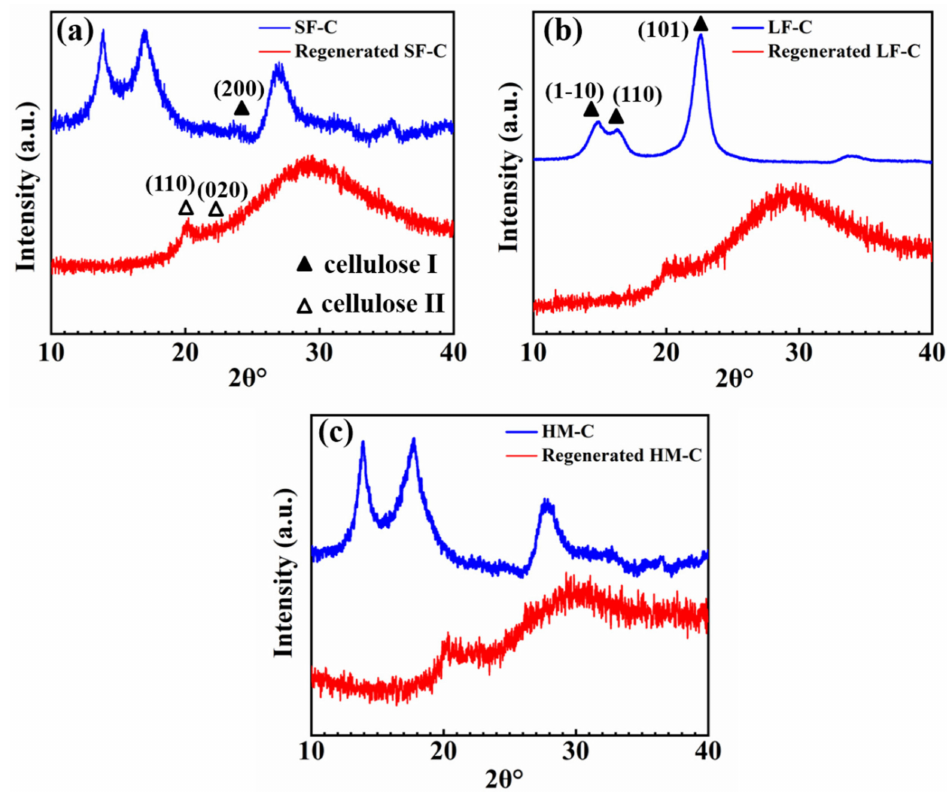
Figure 4. XRD patterns of the cellulose and regenerated cellulose from its glycerin / NaOH aqueous solution: ( a ) SF-C; ( b ) LF-C; ( c ) HM-C.